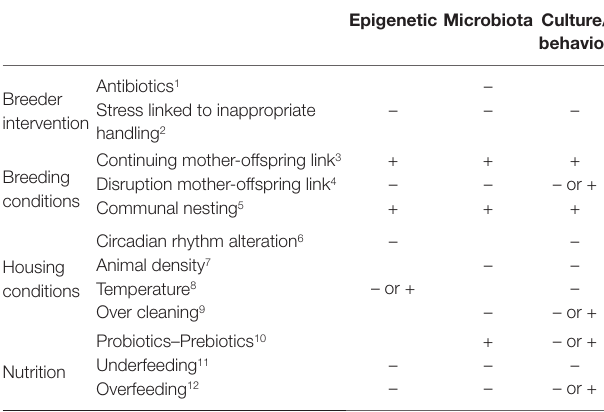
TABLE 1 | Key environmental influences on non-genetic inherited